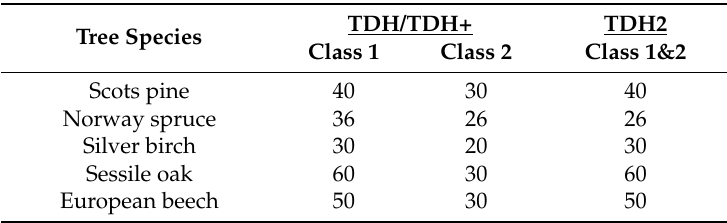
Table 1. Treatment-specific target diameter thresholds (DBH, cm) applied per tree species and timber quality class. Quality class 1 included trees with branches thinner than 6 cm while quality class 2 comprised low quality trees with thicker branches, spike-knots or forks.